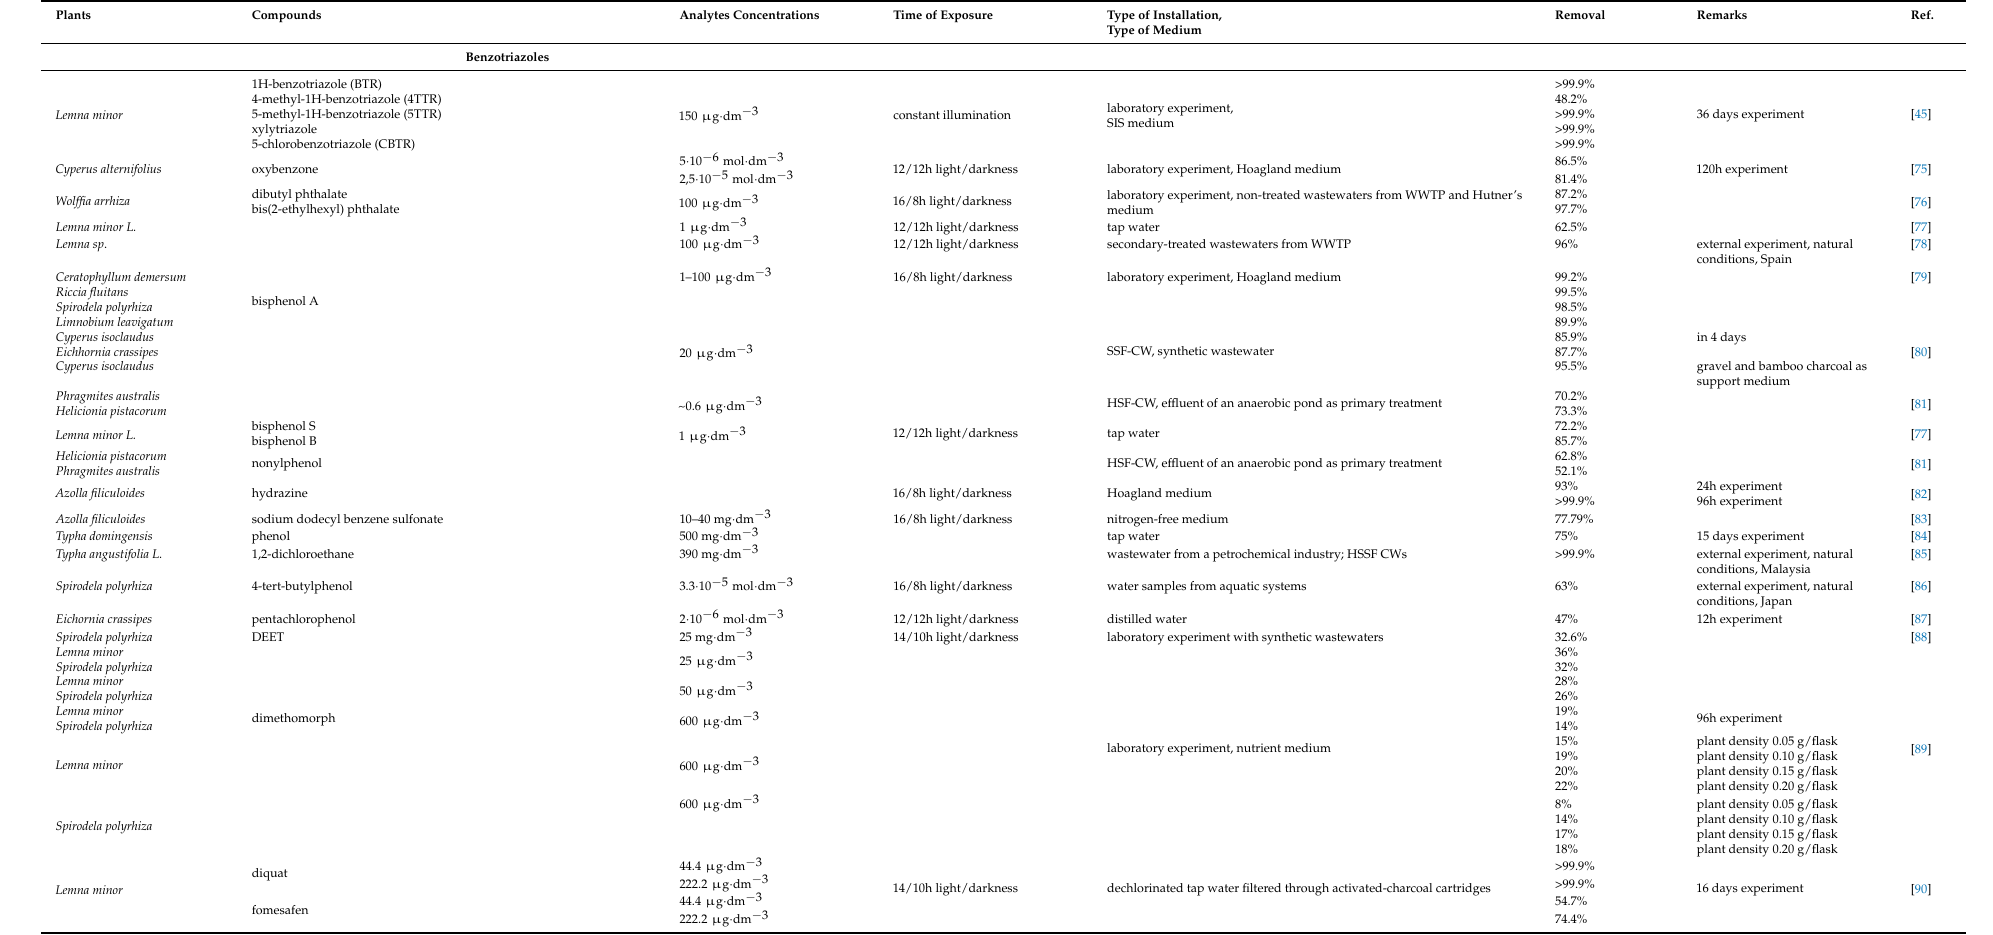
Table 2. Removal efficiency of micropollutants in plants-based